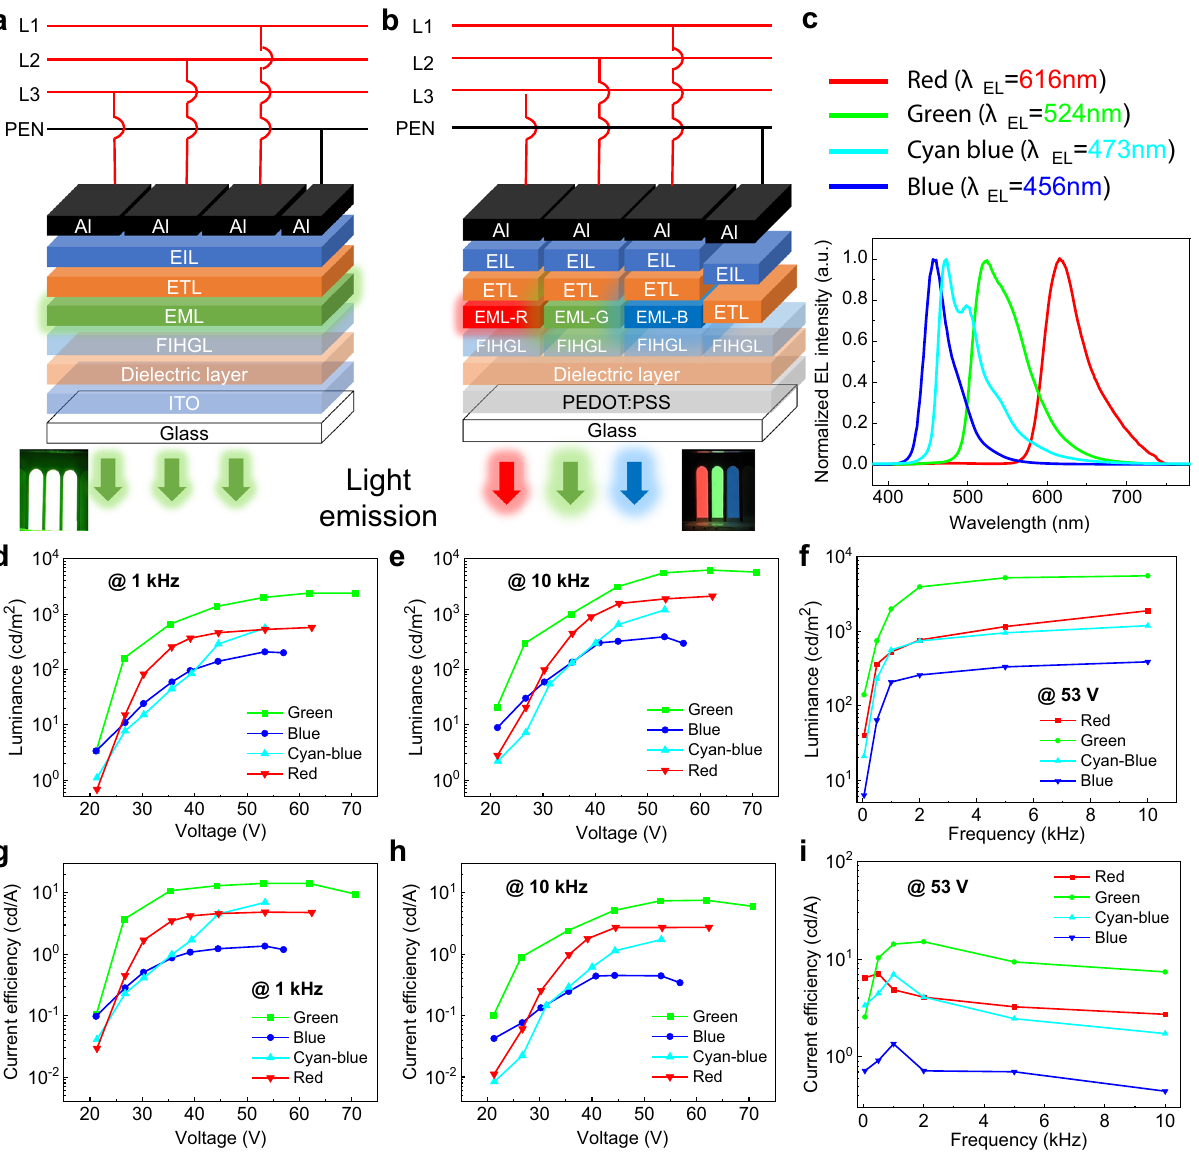
Fig. 6 Schematic representation of TP-OLEDs and their characterization. a Schematic structure of standard TP-OLEDs with a single EML. b Schematic structure of a pixel-formed TP-OLEDs with three uniplanar EMLs emitting red, green, and blue colors. The photographs for both devices are inserted in the bottom. c Normalized EL spectra of TP-OLEDs with different emitters. d Luminance and g current ef fi ciency of standard TP-OLEDs as functions of voltage at the fi xed frequency of 1 kHz. e Luminance and h current ef fi ciency of standard TP-OLEDs as functions of voltage at the fi xed frequency of 10 kHz. f Luminance and i current ef fi ciency of standard TP-OLEDs as functions of AC frequency at the fi xed voltage of 53 V. For green OLED, the ETL layer thickness is 30 nm (see “ Methods ” and Supplementary Information). Source data are provided as a Source Data fi